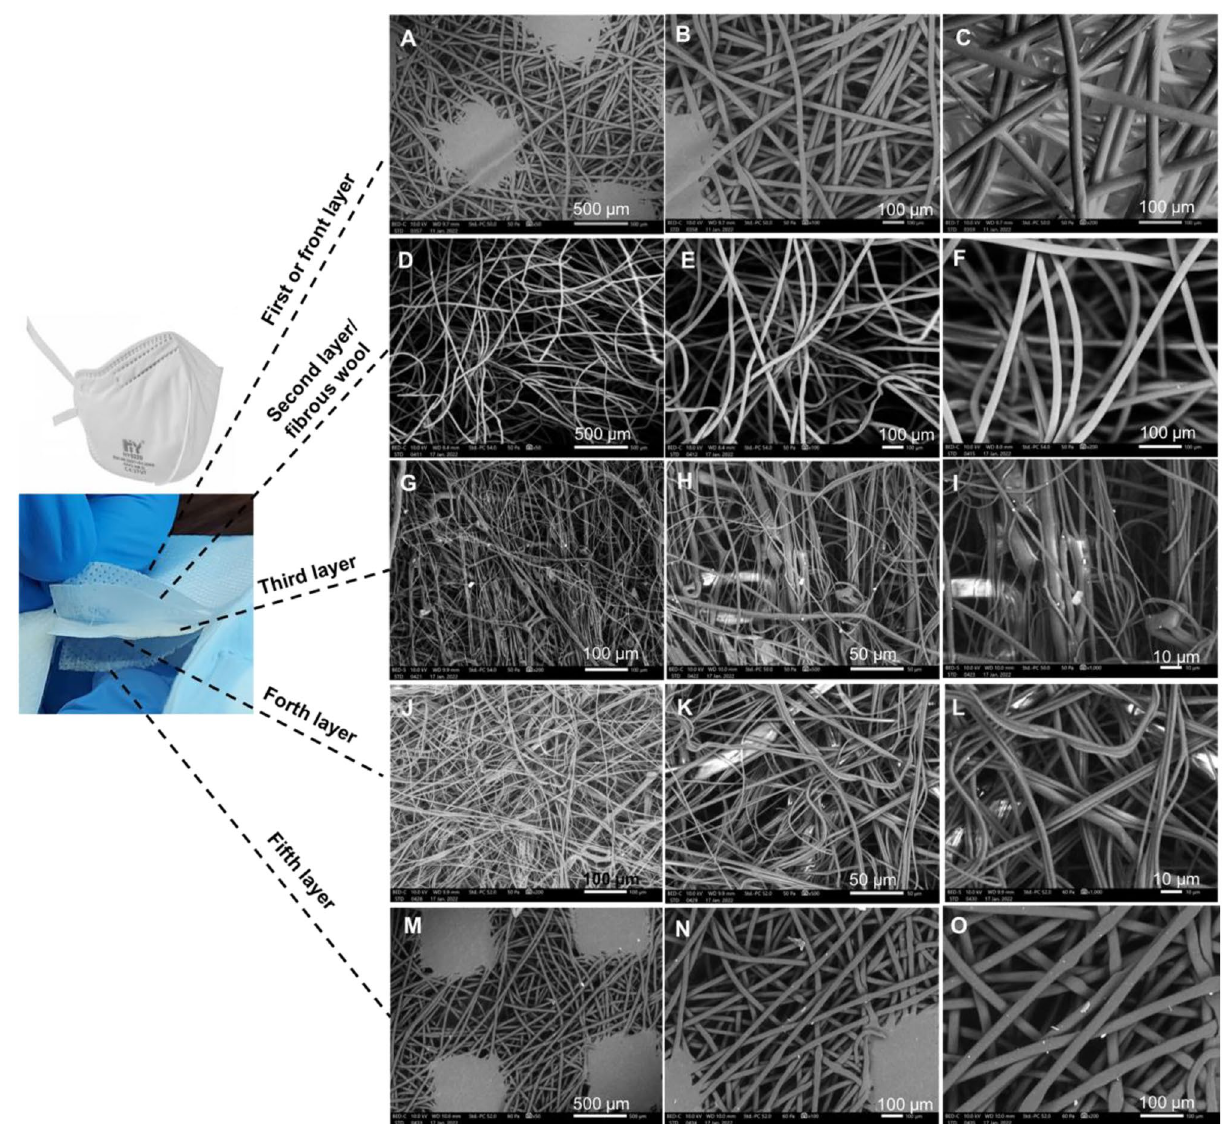
Figure 3. SEM for each of the five layers of a FFP2 mask. ( A – C ) front layer. ( D – F ) second fibrous layer. ( G – I ) third layer. ( J – L ) forth layer. ( M – O ) fifth